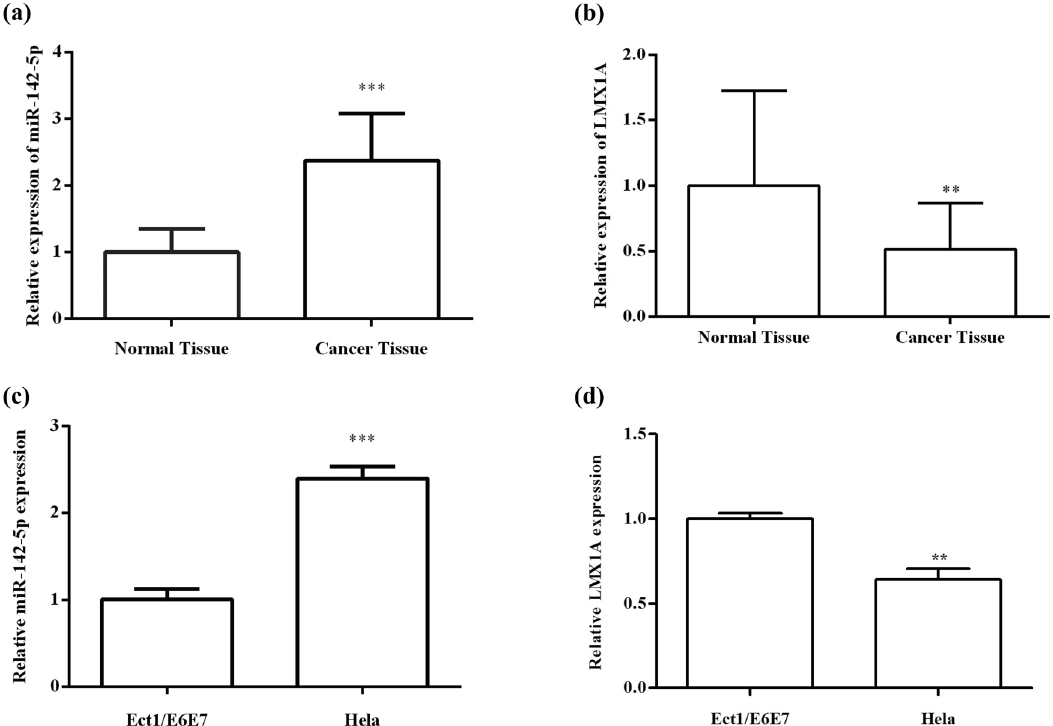
Figure 1: The relative miR - 142 - 5p and LMX1A mRNA expression in cervical cancer tissues and cells were examined by qRT - PCR. Relative miR - 142 - 5p expression levels ( a ) and LMX1A expression levels ( b ) in cervical cancer tissues and paracarcinoma tissues; Relative miR - 142 - 5p expression levels ( c ) and LMX1A expression levels ( d ) in HeLa and Ect1/E6E7. All experiments were performed in triplicate. ** P < 0.01. *** P <